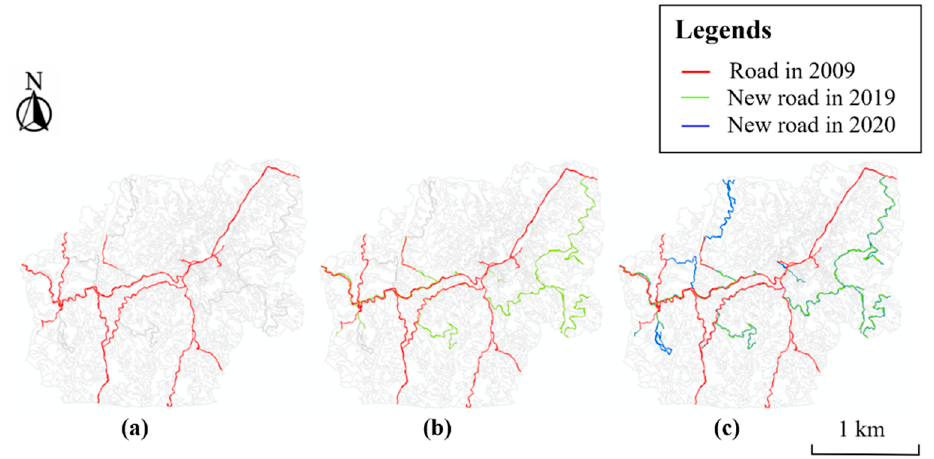
Figure 13. Road changes in ( a ) 2009, ( b ) 2019 and ( c ) 2020.